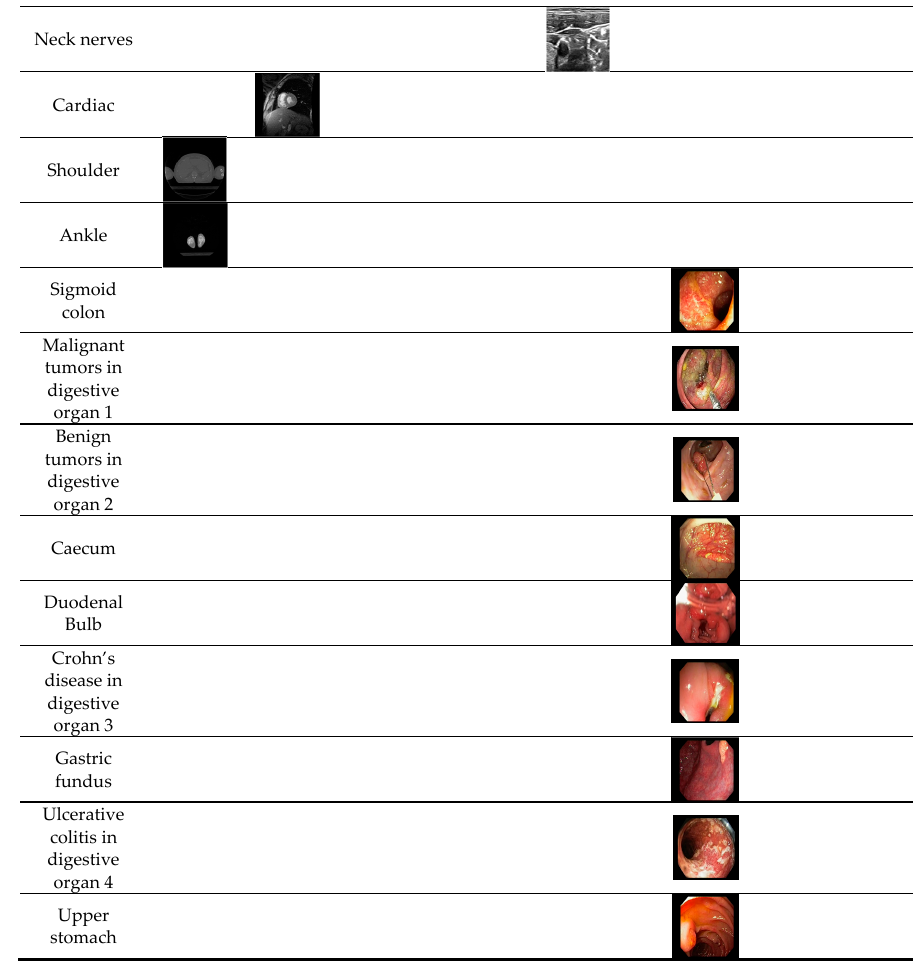
Figure 6. Examples of experimental data of Figure 5 according to the anatomical district (row) and imaging modality (column).